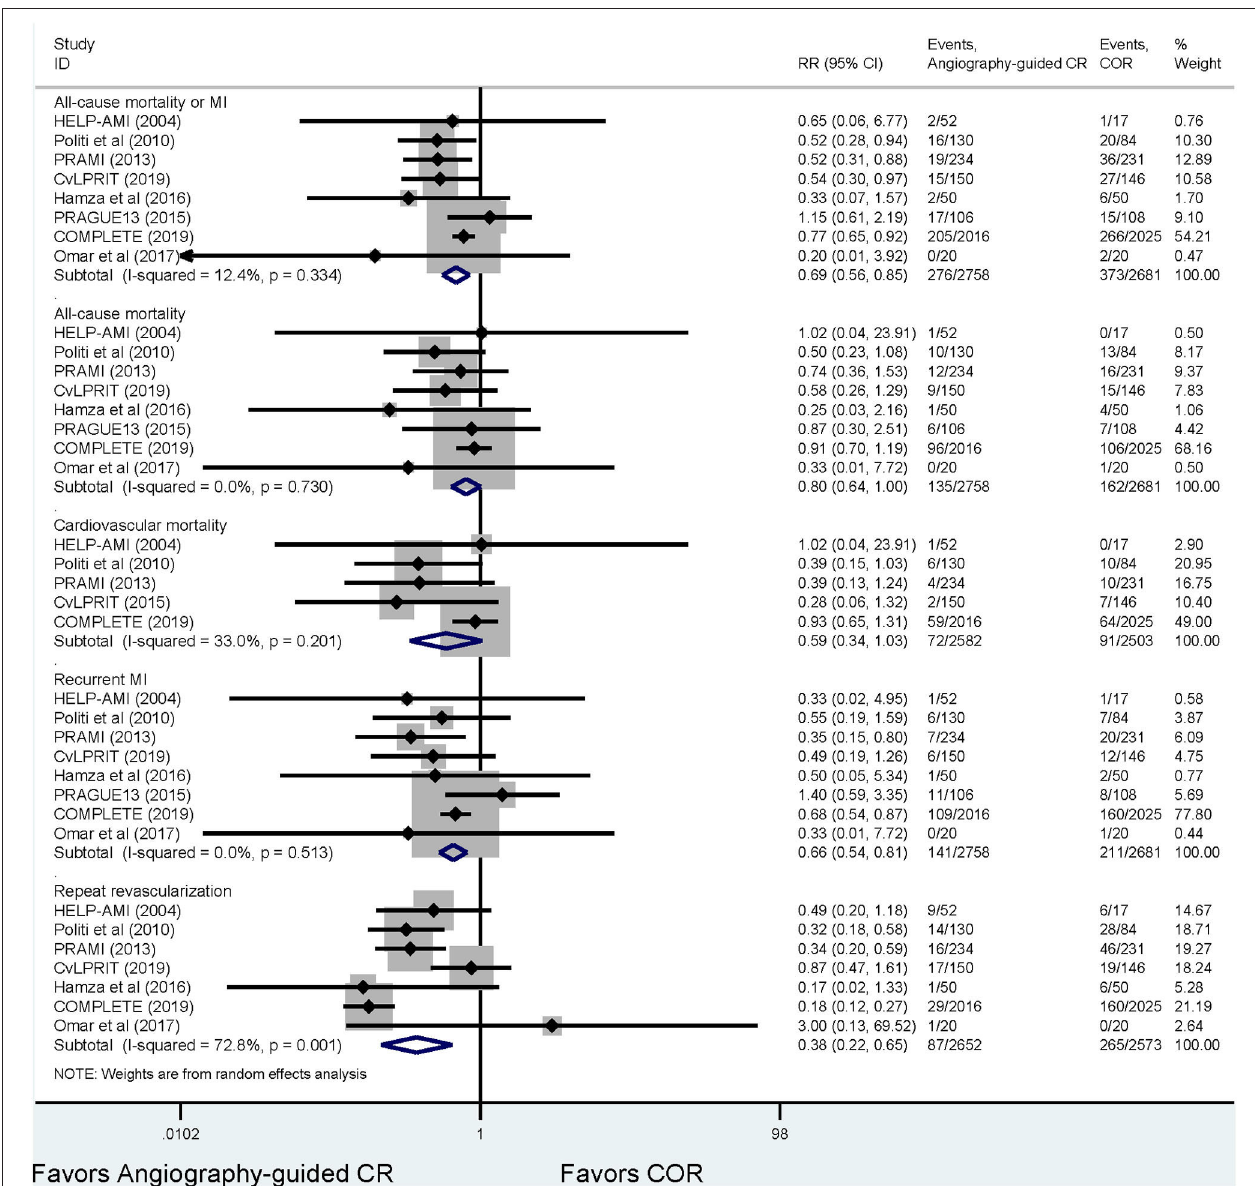
FIGURE 2 | The results of the meta-analysis for the comparison between angiograph-guided complete revascularization and culprit-only revascularization. FFR, fractional flow reserve; COR, culprit-only revascularization; CR, complete revascularization; MI, myocardial